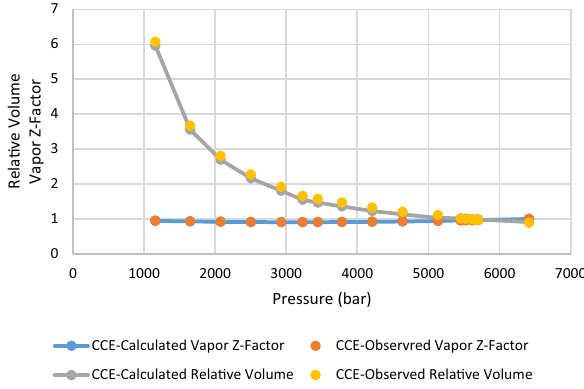
Fig. 2 CCE relative volume and vapor Z-factor results under labora- tory conditions (108.8 °C)